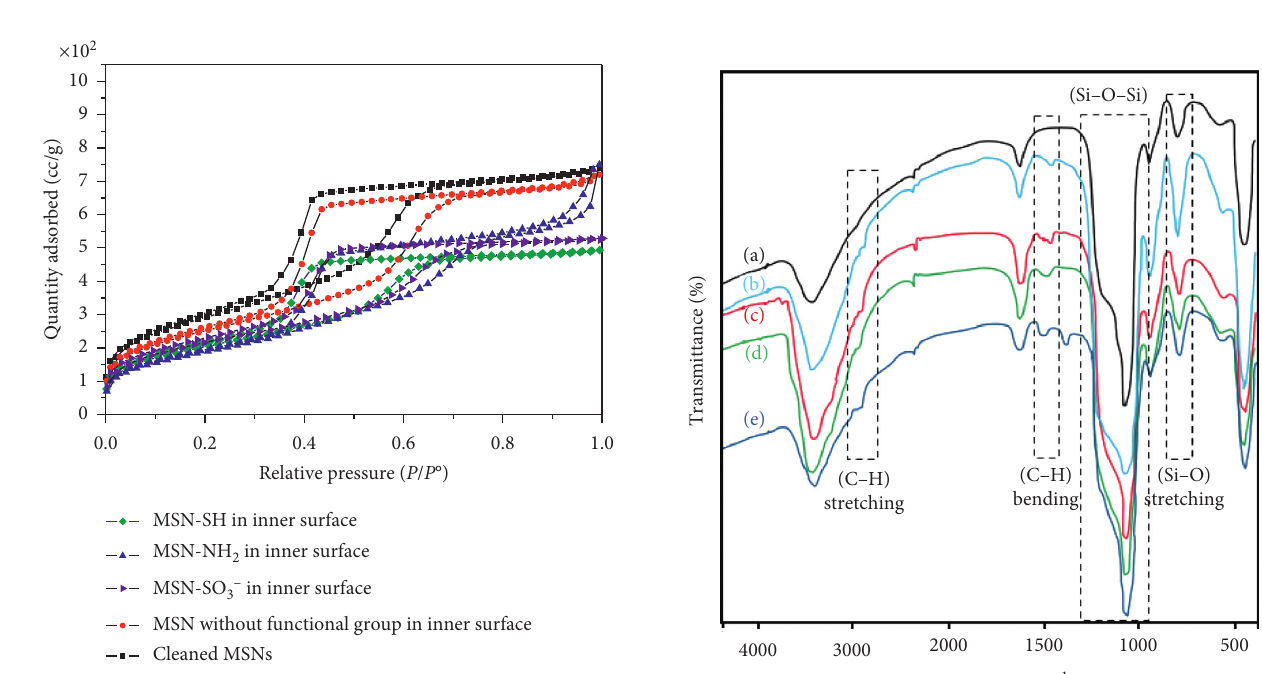
Figure 2: Nitrogen adsorption isotherms of ( ■ black) bare MSNs, ( ● red) TMPAC-MSNs, ( ▲ blue) TMPAC-MSNs -NH 2 , ( ◆ green) TMPAC-MSNs-SH, and ( ■ purple) TMPAC-MSNs-SO −